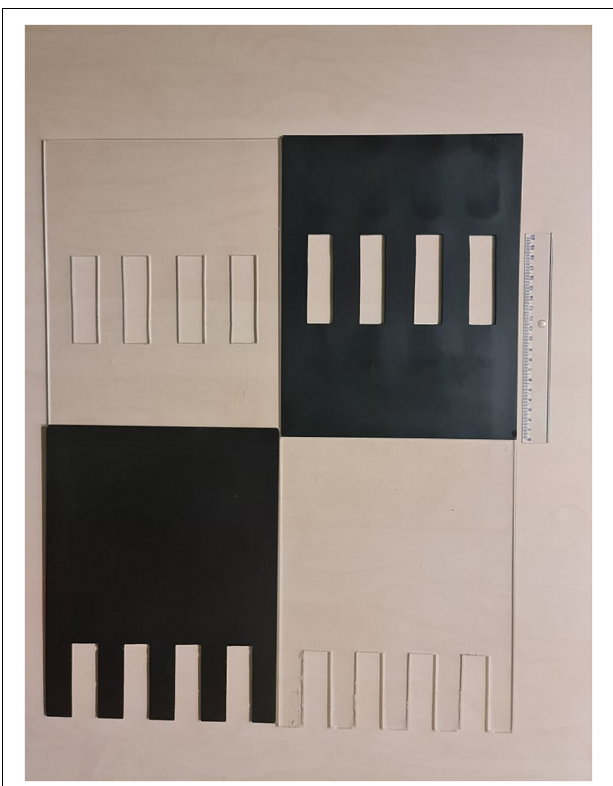
FIGURE 2 | At the top of the figure are two middle partitions, and at the bottom are two outer partitions. The black opaque versions are alternatives to implement the deprivation of visual cues. The results presented in this study were obtained using the transparent version.